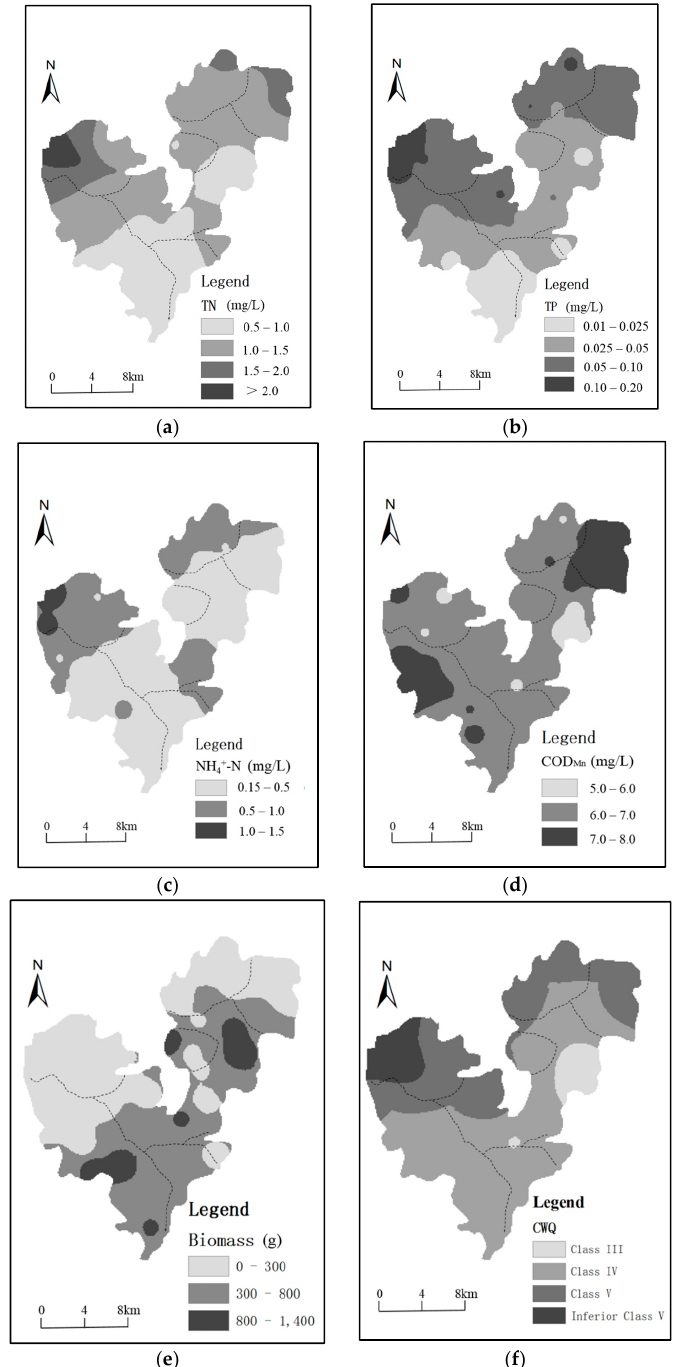
Figure 4. Spatial variability in water quality parameters, biomass, and composite water quality: ( a ) TN; ( b ) TP; ( c ) NH 4+ –N; ( d ) COD Mn ; ( e ) Biomass; and ( f ) CWQ.